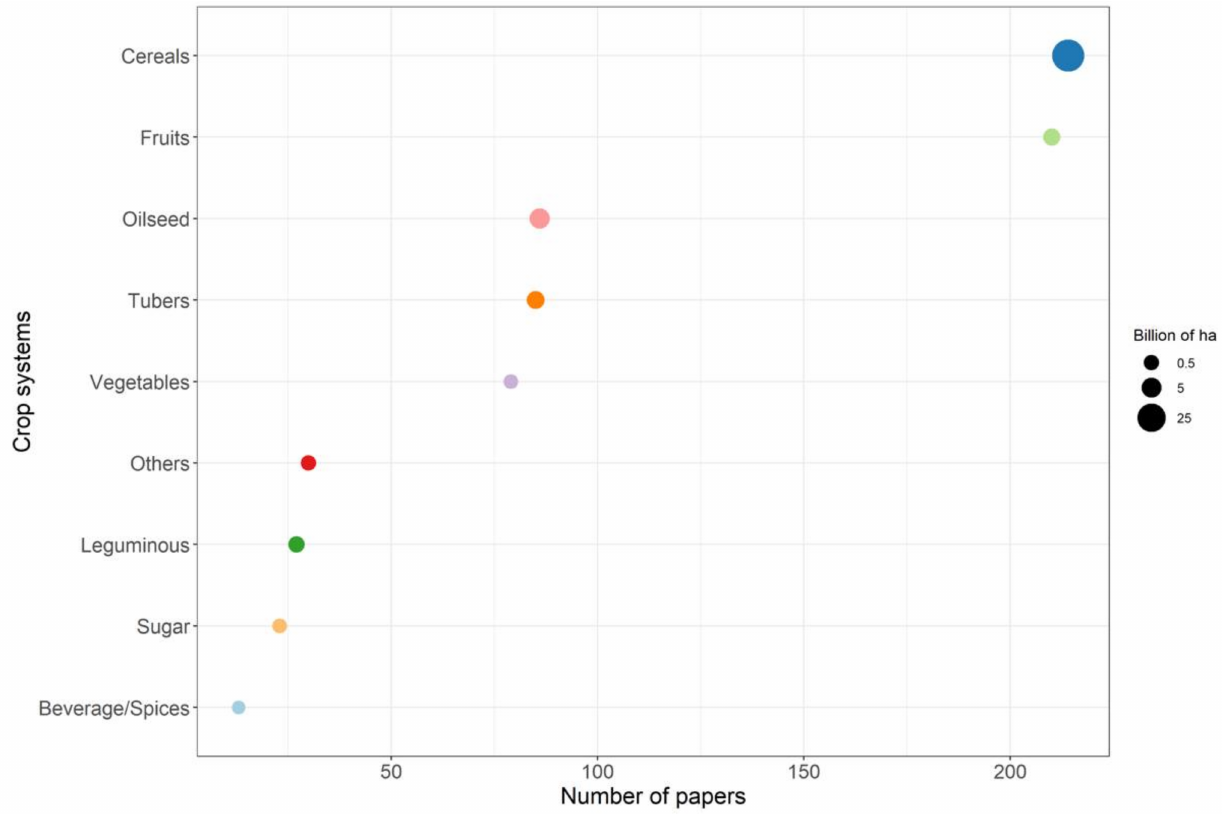
Figure 4. Number of papers grouped by crop system. The dot size indicates the global cultivated area for each crop